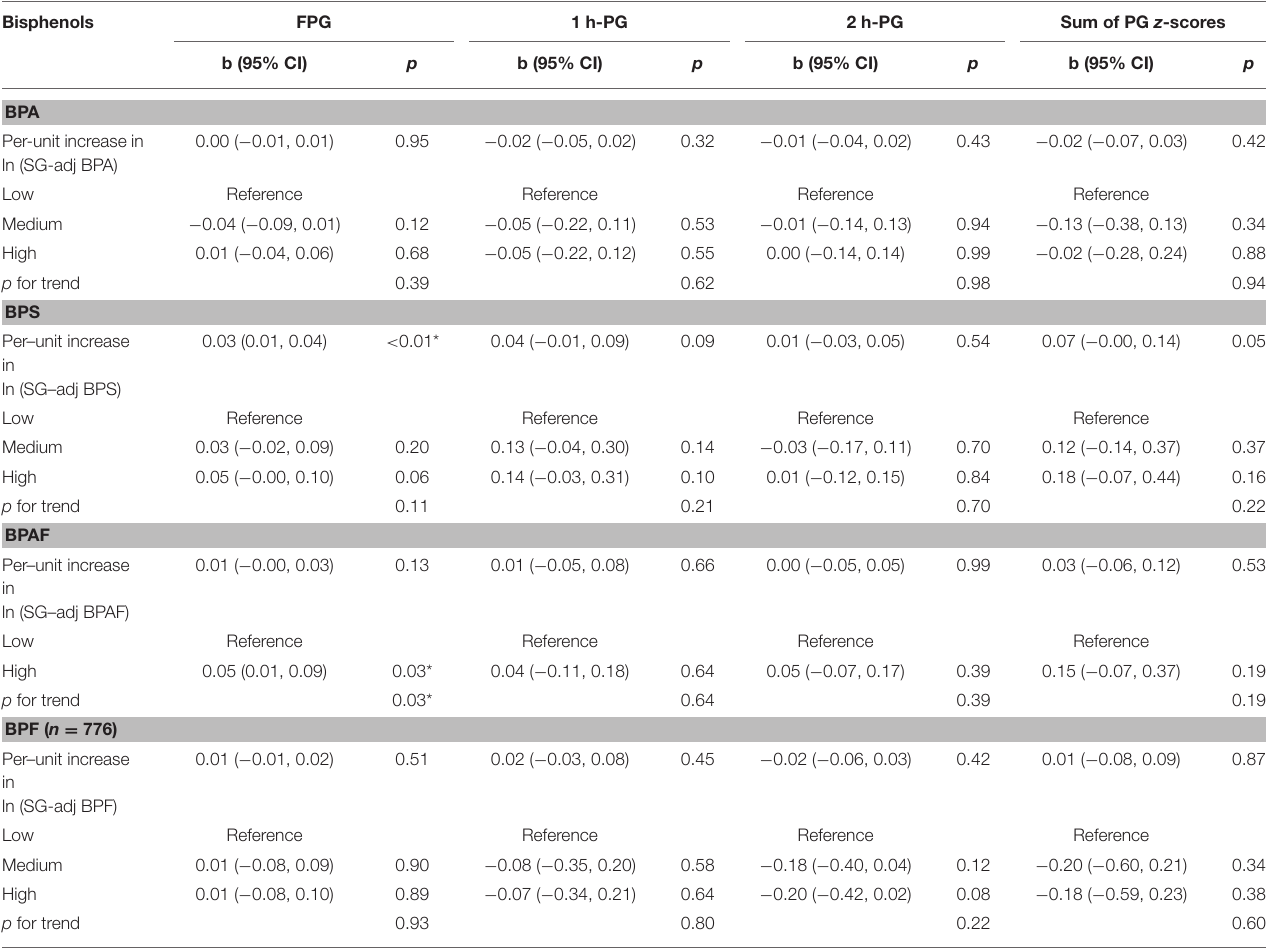
TABLE 4 | Associations of urinary bisphenols and glucose levels among all participants ( n = 1,841) a .